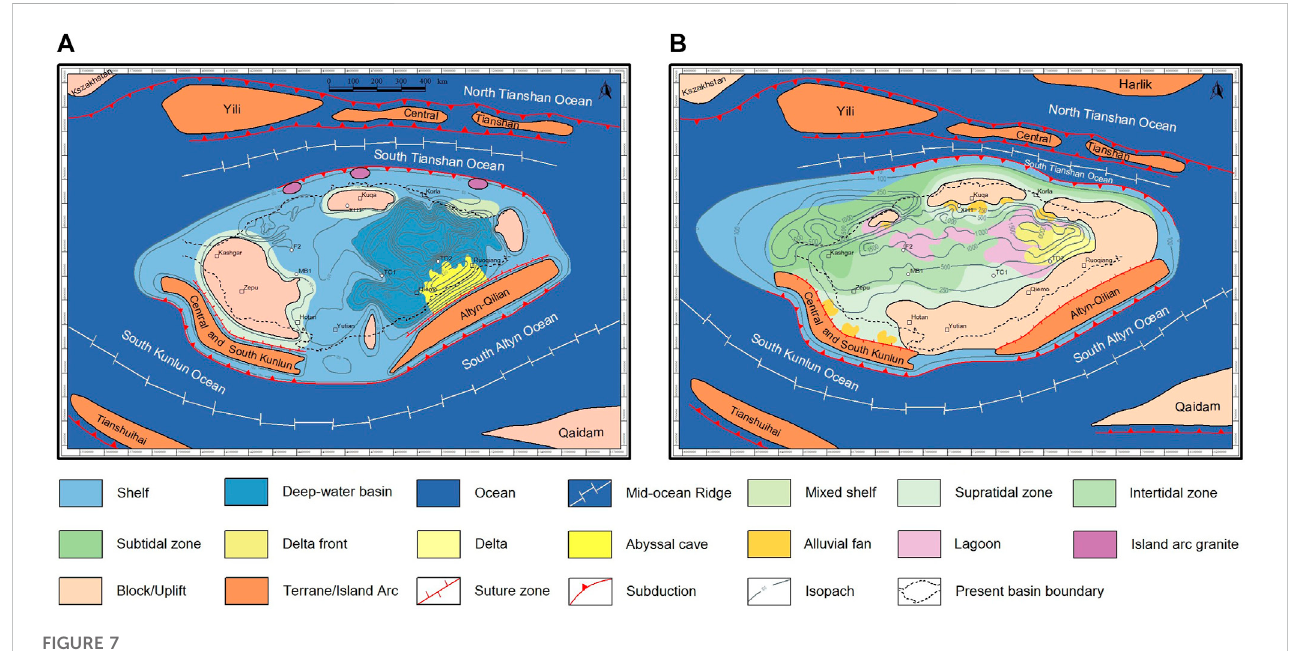
FIGURE 7 Proto-type basin of Tarim and adjacent areas in late Ordovician (A) and late Silurian (B)